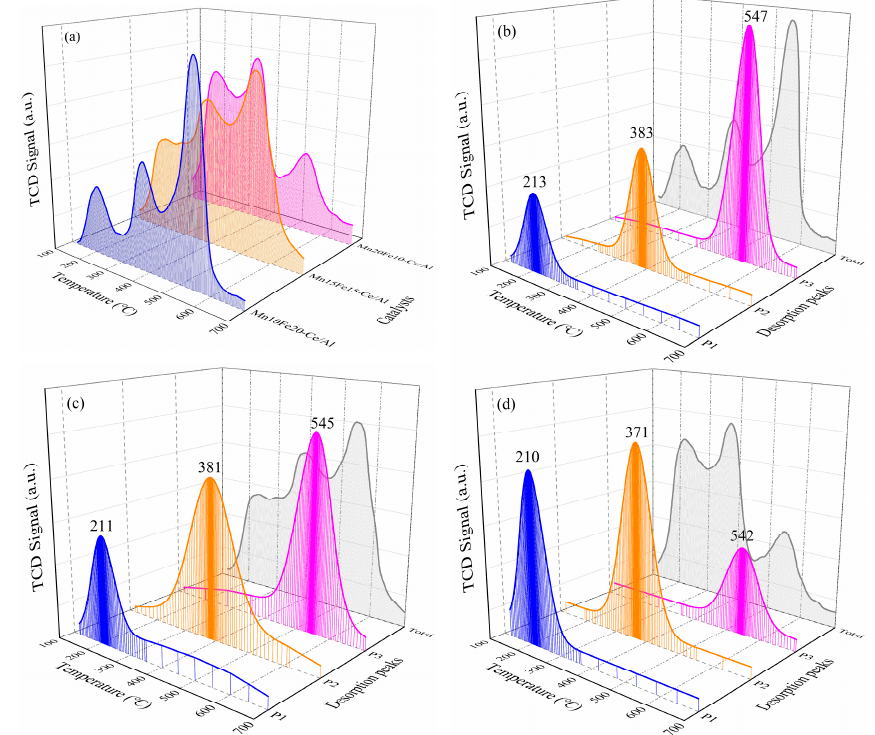
Figure 6. NH 3 -temperature-programmed desorption (NH 3 -TPD) profiles of Mn − Fe − Ce − O x / γ - Al 2 O 3 nanocatalysts: ( a ) total NH 3 -TPD curves; ( b ) multi-peak Gaussian fitting for Mn10Fe20 − Ce/Al sample; ( c ) multi-peak Gaussian fitting for Mn15Fe15 − Ce/Al sample; ( d ) multi-peaks Gaussian fitting for Mn20Fe10 − Ce/Al